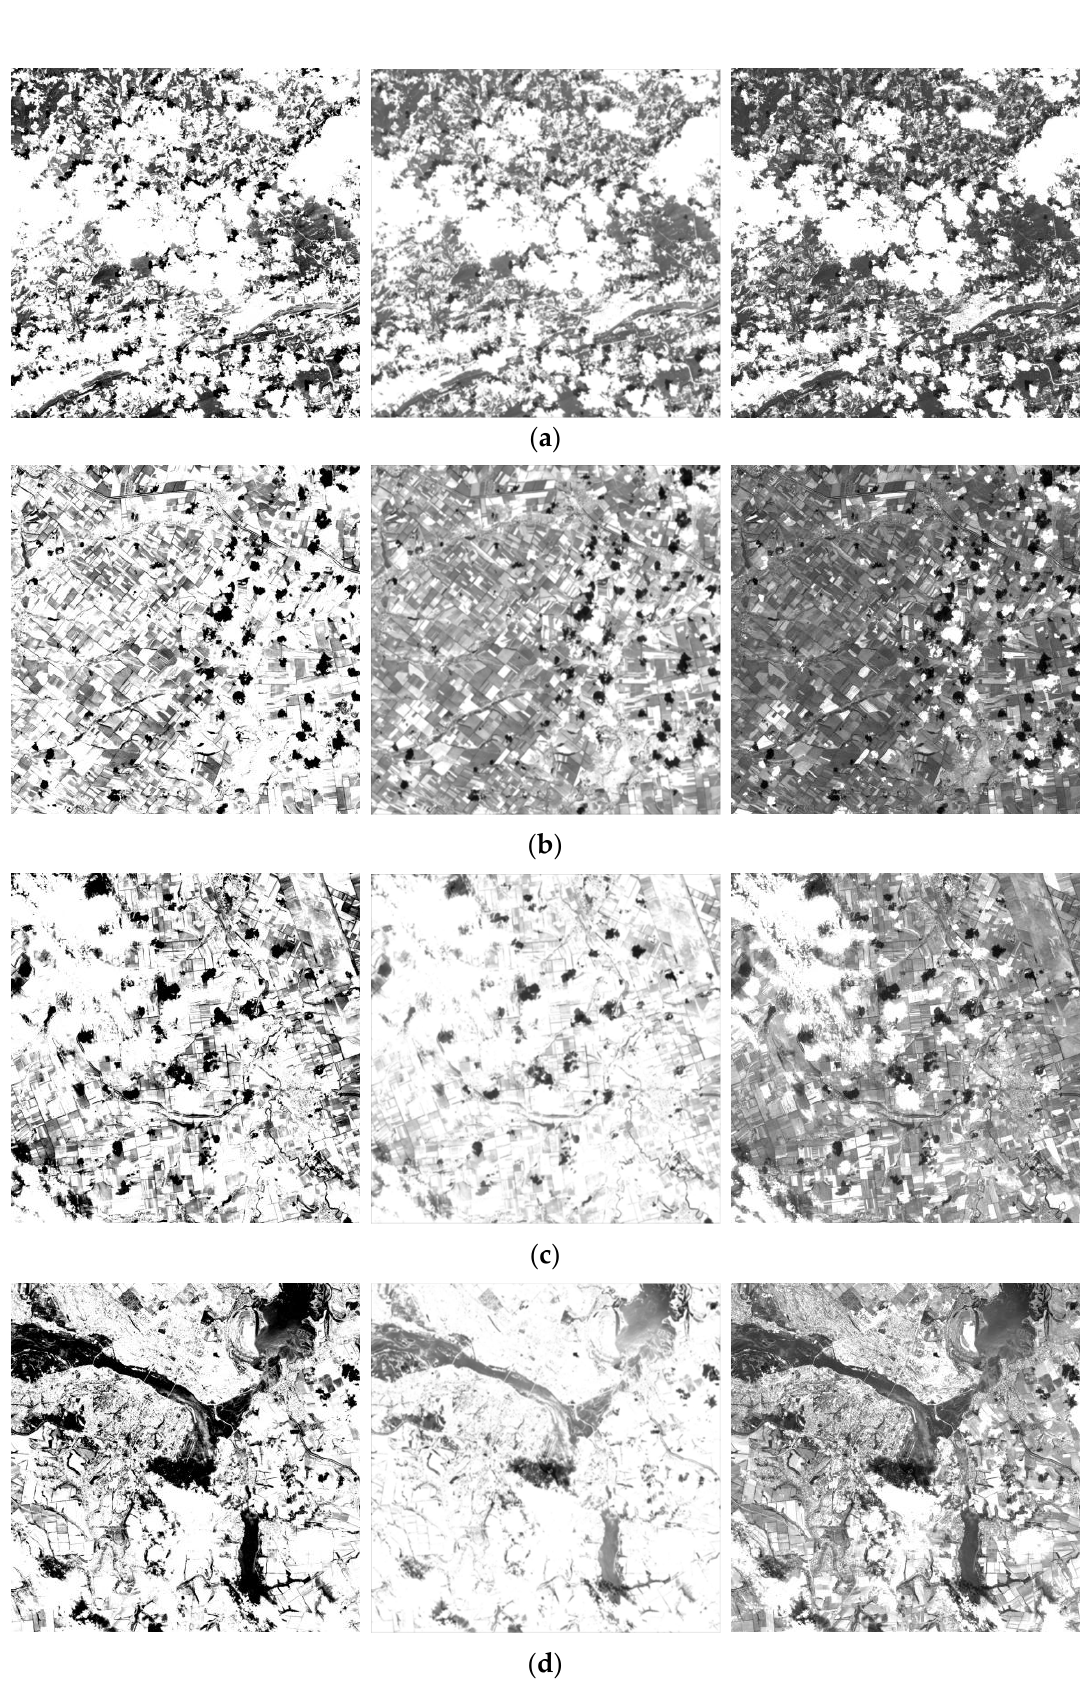
Figure 16. Image enhancement effect: ( a ) cloudy image, ( b ) urban image with thin cloud, ( c ) urban image with thick cloud and ( d ) suburban image. Left : LGP [ 69 ]; Middle : CVT [ 64 ]; Right : Ours.